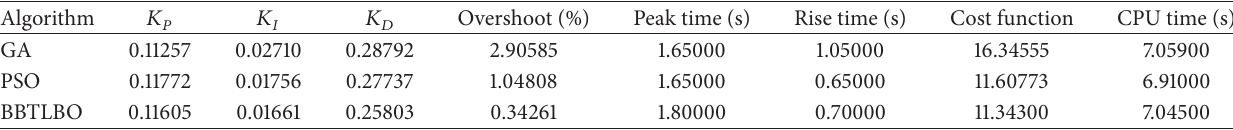
Table 7: Comparisons of parameters of PID controllers using different algorithms.